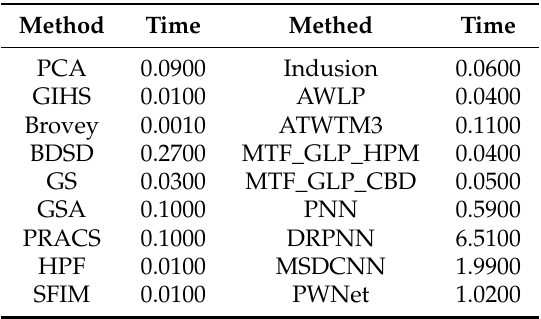
Table 10. Running time comparison of different methods (in